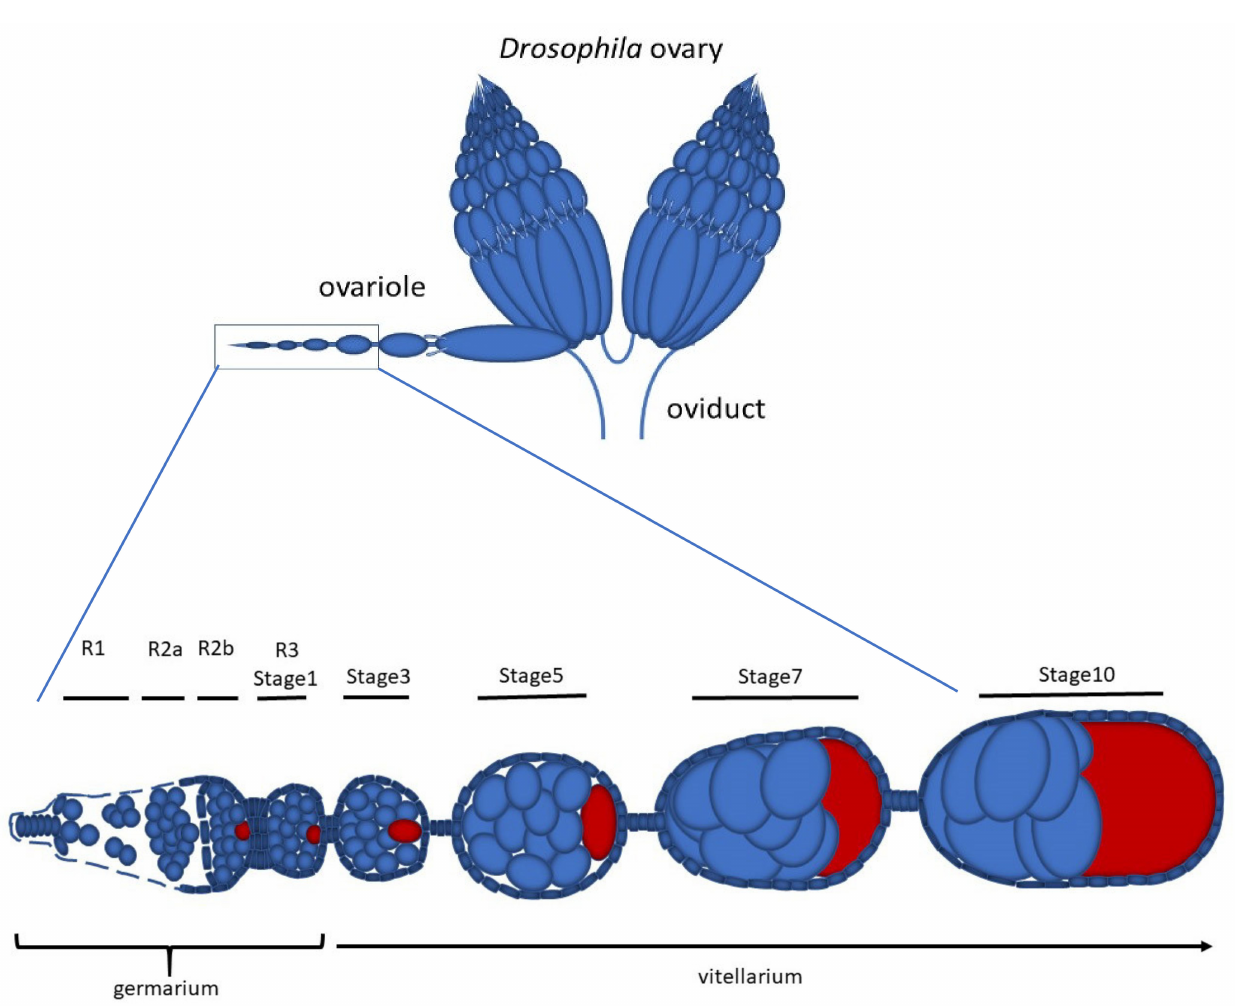
Figure 1. Schematic representation of the Drosophila ovary and detail of an ovariole showing stages of egg chamber development; the oocyte is